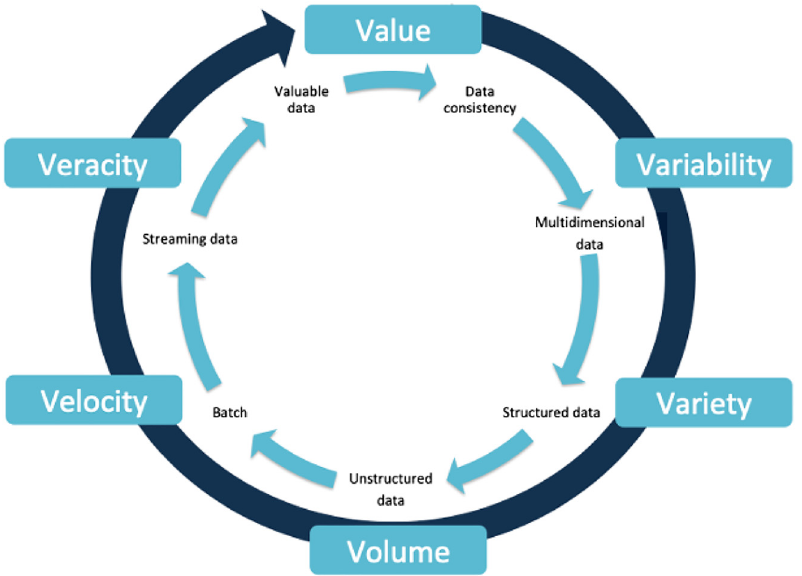
Figure 1: Features of big data. The cardinal features of big data must be built based on the value, variability, variety, vol- ume, velocity and veracity, in order to achieve those features, the inner circle shows the